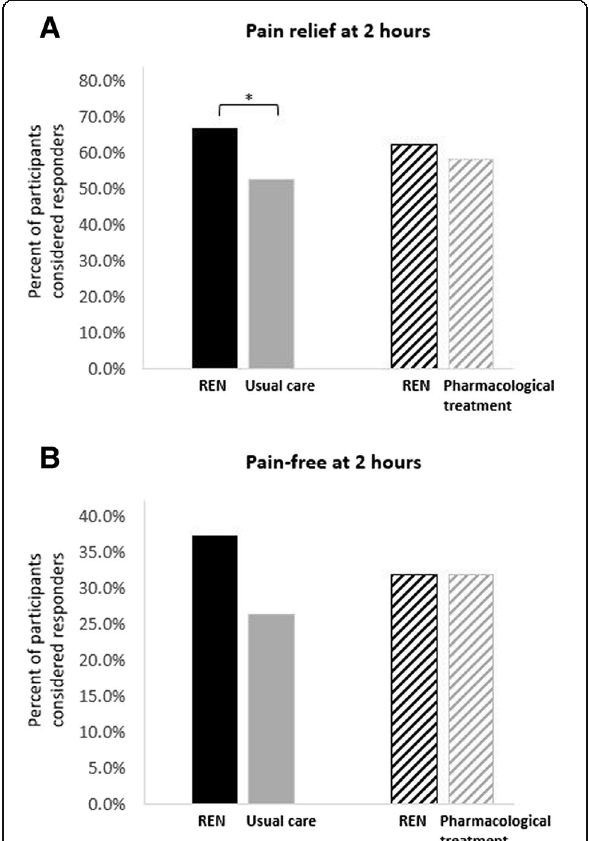
Fig. 3 Efficacy comparison of pain responses in at least 1 of 2 attacks. a Pain relief at 2 h post-treatment in at least 1 of 2 attacks following REN treatment (solid black and diagonal black) compared with usual care (solid gray) and pharmacological treatment (diagonal gray). b Pain-free at 2 h post-treatment in at least 1 of 2 attacks following REN treatment (solid black and diagonal black) compared with usual care (solid gray) and pharmacological treatment (diagonal gray). * p <